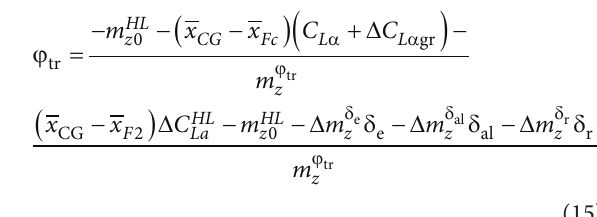
as function of δ j.k Rz m